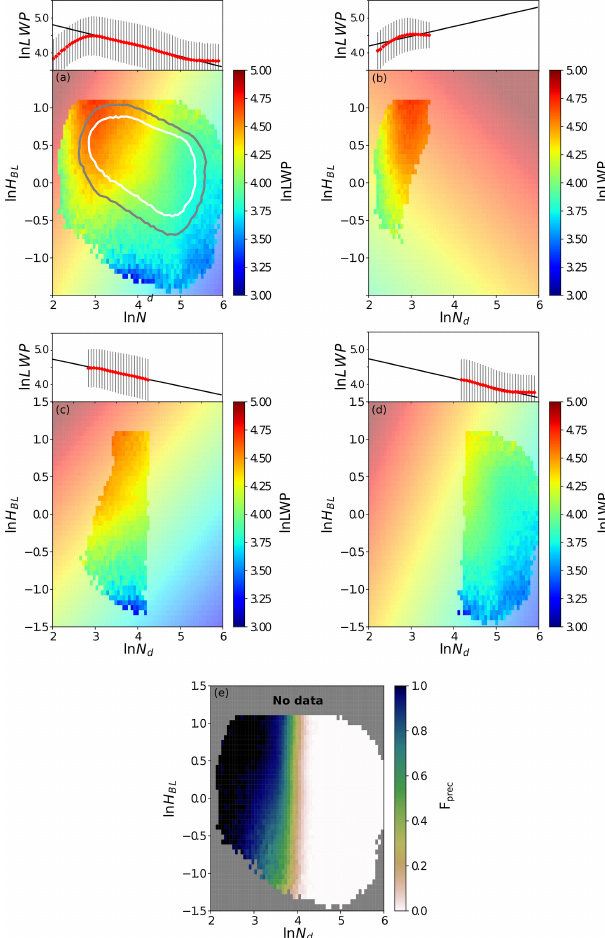
Figure 4. Climatology of lnLWP against ln N d and ln H BL for (a) all subtropical stratocumulus (see Fig. 2), (b) fully precipitat- ing stratocumulus, (c) intermittently precipitating stratocumulus, and (d) non-precipitating stratocumulus. Points are classified as fully precipitating (non-precipitating) if the fraction of precipitat- ing cloud scenes shown in (e) exceeds 0.98 (remains below 0.02). All other cloud scenes are classified as intermittently precipitating. At the top of panels (a) – (d) , lnLWP binned in ln N d is shown as in Gryspeerdt et al. (2019). A minimum number of 100 points within each ln N d –ln H BL bin was required to be included in the climatol- ogy shown in opaque contours (a–e) . The bivariate (simple linear) regression across the two-dimensional (one-dimensional) climatol- ogy is shown in transparent contours (as black line) in panels (a) – (d) . White and grey lines in (a) denote the region of the phase space containing 80% and 90% of all data, respectively. The slopes of all fits are summarised in Table